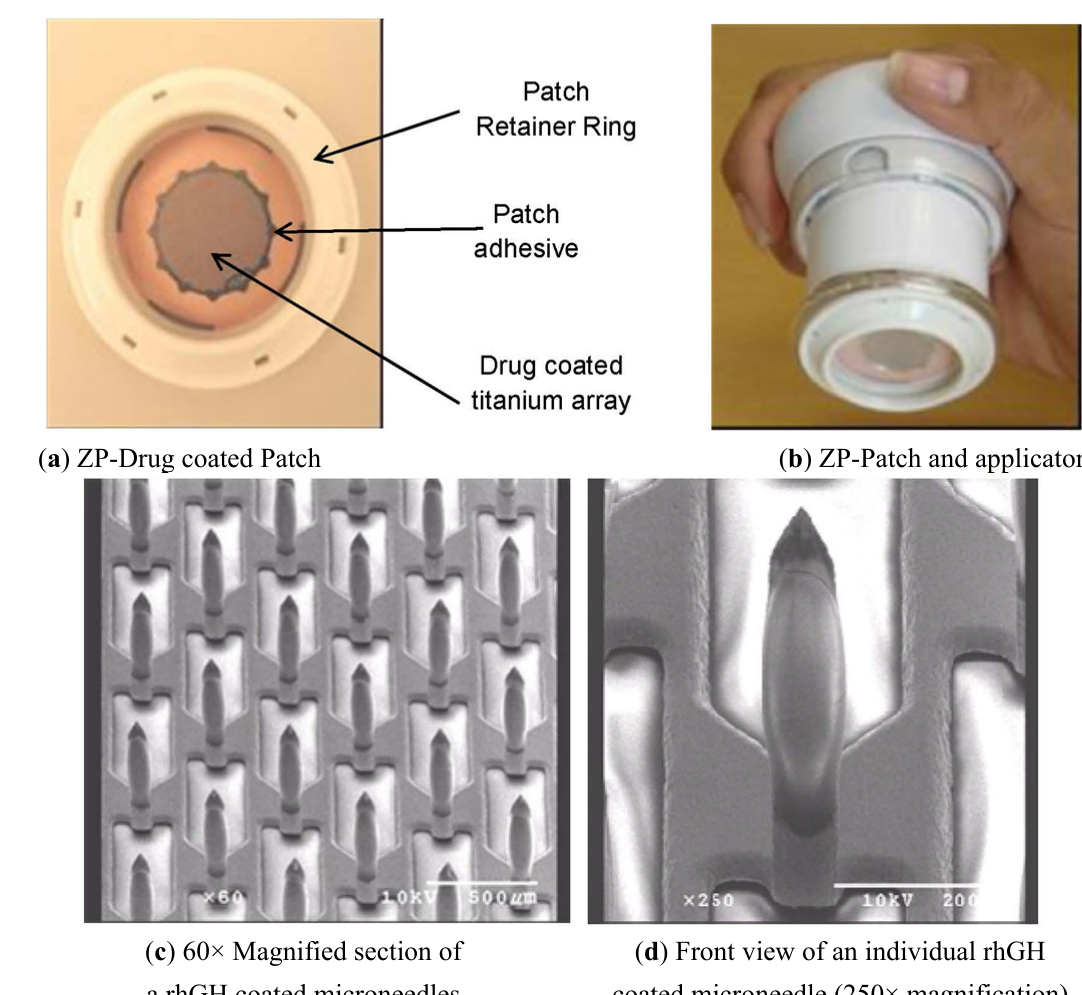
Figure 1. Transdermal microneedle patch delivery system ( a ) 5 cm 2 adhesive patch with microneedle array (3 cm 2 ) in applicator ring; ( b ) Zosano Pharma (ZP)-Patch press fit onto the bottom of the applicator; and applicator; ( c ) 60× magnification of recombinant human growth hormone (rhGH) coated microneedles (580 microneedles/cm 2 , length 340 µm and tip angle 60°), rhGH coated at 0.5 mg/3 cm 2 array; and ( d ) Front view of an individual rhGH coated microneedle (250×